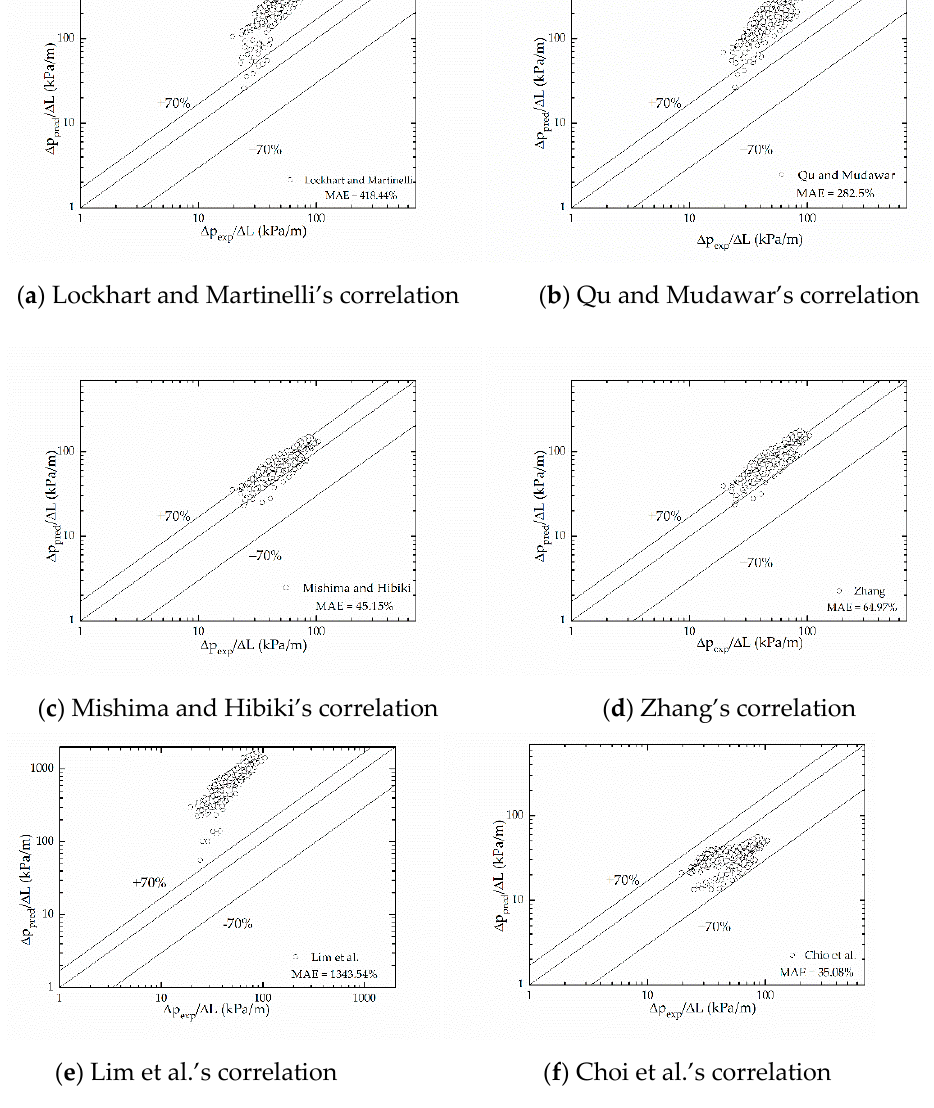
Figure 8. Comparison of measured frictional pressure drop data with predictions of separated flow correlations proposed by ( a ) Lockhart and Martinelli, ( b ) Qu and Mudawar, ( c ) Mishima and Hibiki, ( d ) Zhang, ( e ) Lim et al. and ( f ) Choi et al. Lockhart and Martinelli’s [16] correlation is widely used in conventional size tubes.